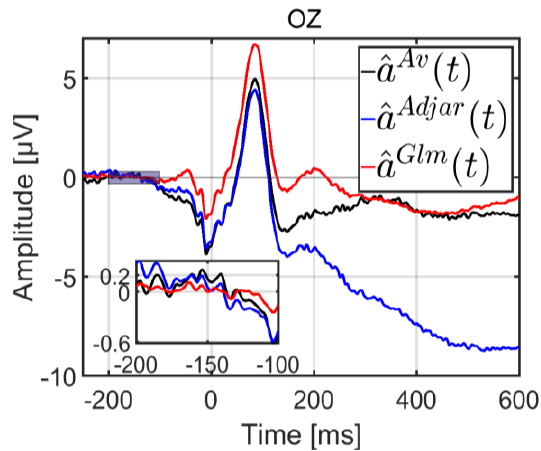
Figure 2 Grand average for the three methods: Average ( 𝑎̂ 𝐴𝑣 (𝑡) ), ADJAR ( 𝑎̂ 𝐴𝑑𝑗𝑎𝑟 (𝑡) ), and GLM ( 𝑎̂ 𝐺𝑙𝑚 (𝑡) ) on the OZ electrode; the inset is a zoomed plot between -200 and -100 ms Statistical comparison of the variance during the baseline interval, between -200 and -100 ms, revealed that the var- iance of the estimate 𝑎̂ 𝐺𝑙𝑚 (𝑡) was lower than the variance of estimates 𝑎̂ 𝐴𝑣 (𝑡) and 𝑎̂ 𝐴𝑑𝑗𝑎𝑟 (𝑡) ( 𝐹(2, 99) = 13.86 , 𝑝 < 0.001 , and Bonferroni adjustment for multiple compari- sons). The zoomed plot can be seen in Figure 2. The base- line correction for this period was therefore erroneous for both the ADJAR algorithm and the Average method.